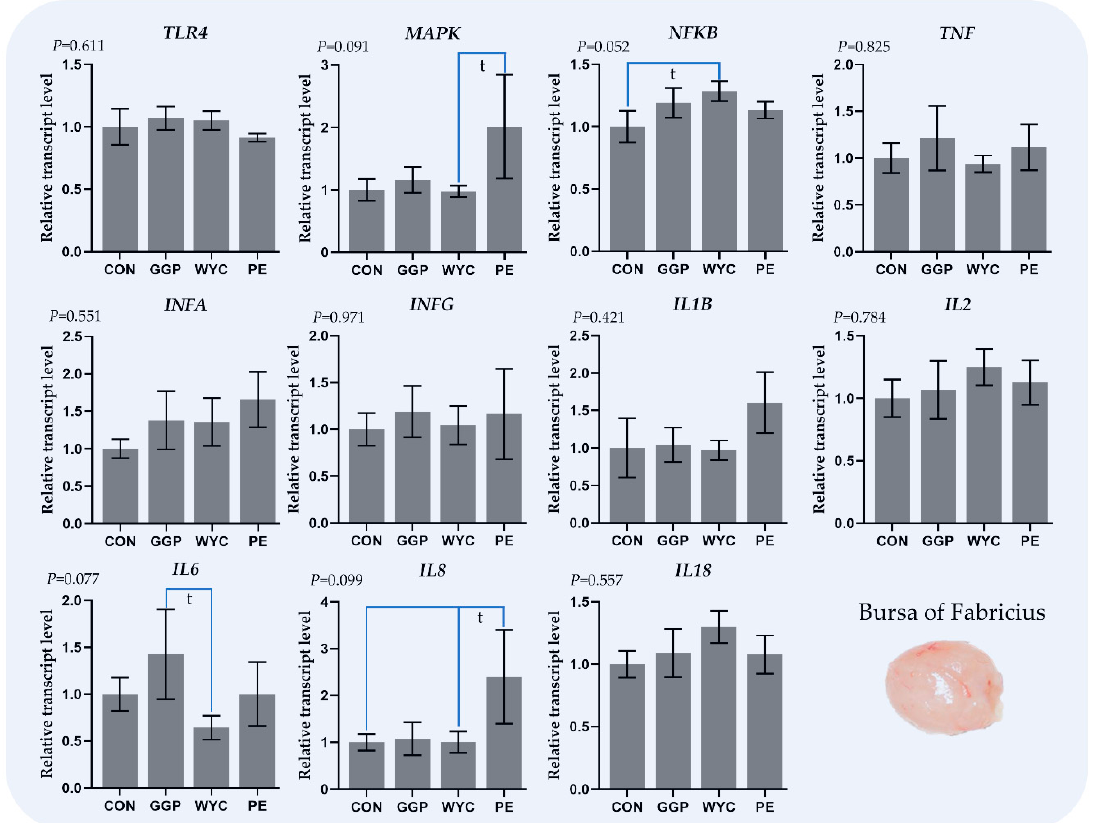
Figure 2. Relative transcript levels (means ± SEM) of immune-related genes in the bursa of Fabricius of 42-day-old broilers. Bars with different letter (a, b) amongst the treatments differ significantly ( p ≤ 0.05), while t represents 0.05 < p- value < 0.10.